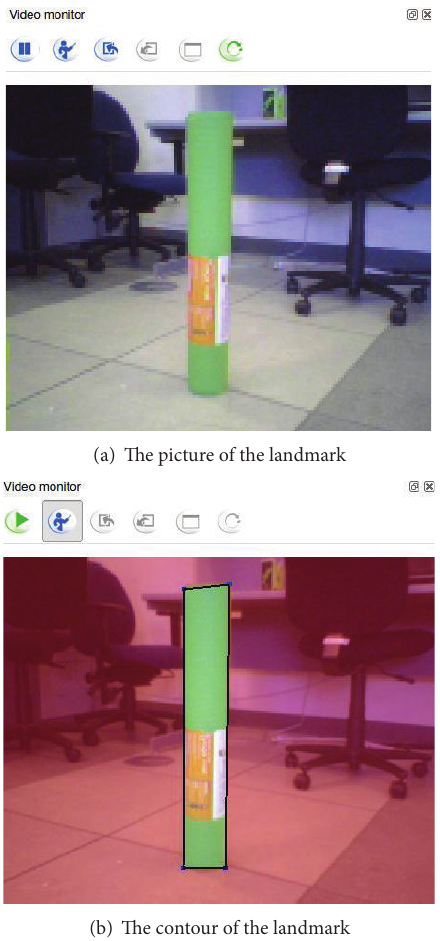
Figure 5: The process of the recognized landmarks.